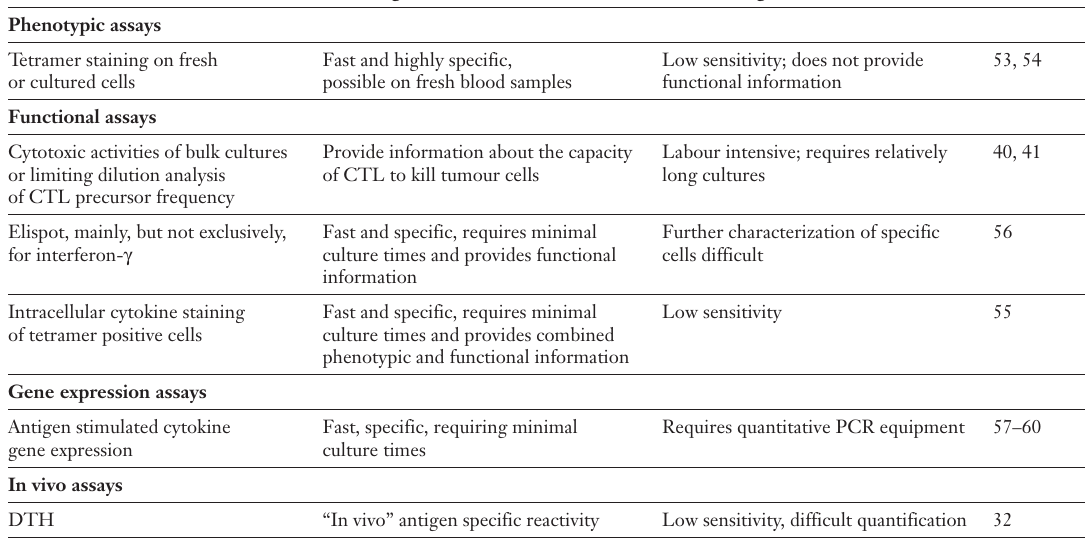
An overview of technologies currently in use in the monitoring of active antigen spe- cific immunotherapy of